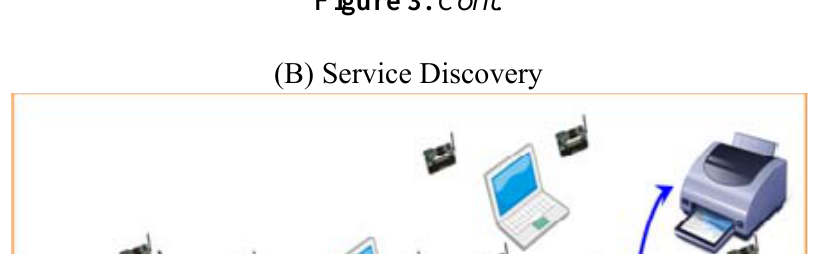
Figure 3. Cont . (B) Service